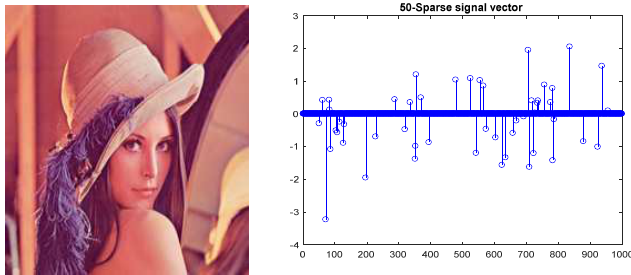
Figure 10. An illustration of a video streaming with the first picture and the rest are some changing if the video streaming may have. The first picture and 1000 random Gaussian scalar values representing the differences between 1000 pictures including the first one.